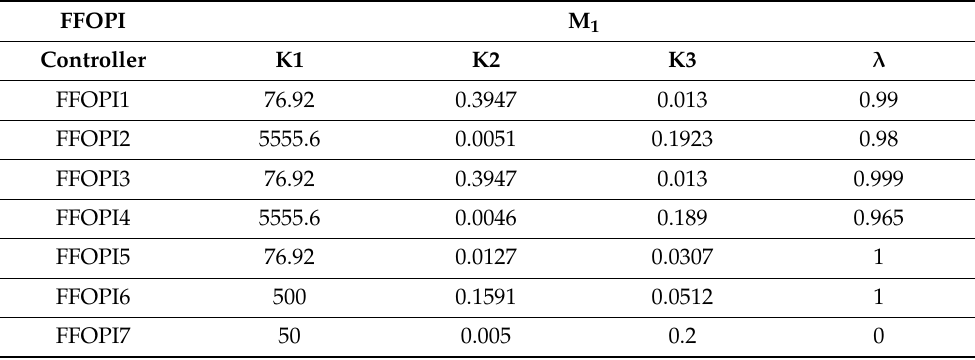
Table 7. FFOPI controller gains of microgrid system M 1 in the case of VIC.